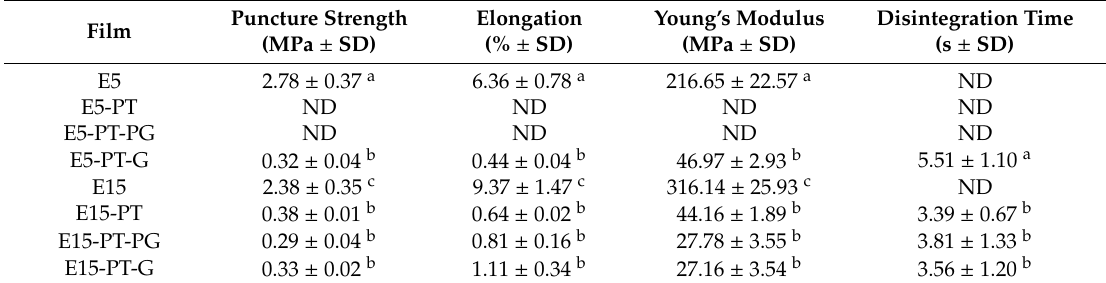
Table 4. Mechanical parameters and disintegration time of 3D-printed